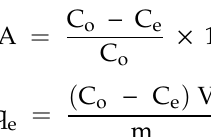
Figure 4. Effect of pH for the adsorption of As(III) using PP@TiO 2 from water: ( a ) Adsorption % of As(III) by PP@TiO 2 ; ( b ) Distribution coefficient (K D ) of As(III) adsorption at different pH. (Conditions: m = 25 mg, V = 25 mL, V:m = 1000 mL/g, T = 25 °C, contact time = 24 h). The equilibrium data were fitted using two binding models, Langmuir and Freundlich. The Langmuir model assumes the saturated monolayer adsorption on the homogenous and energetically identical adsorption sites, and no significant interaction between adsorbed species, which is expressed according to Equation (4) in the linear form [62] as: C e q e = 1 q m b + C e q m